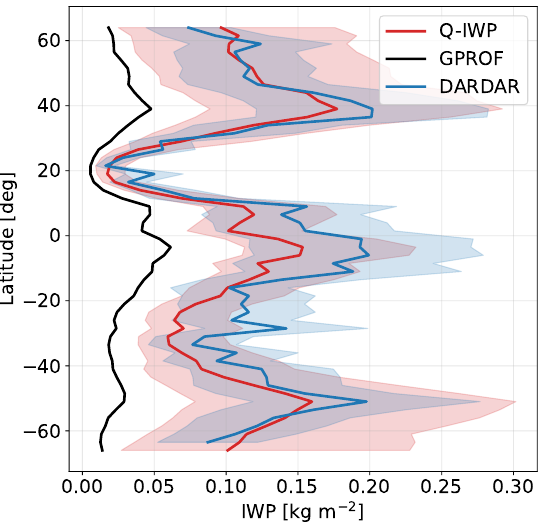
Figure 15. The zonal means of Q-IWP, GPROF and DARDAR observations for January 2017. The blue shaded region for DARDAR corresponds to the ± 40% uncertainty, while the limits of the red shaded region are the mean of the 5% and 95% percentiles. For DARDAR, only daytime observations were available.